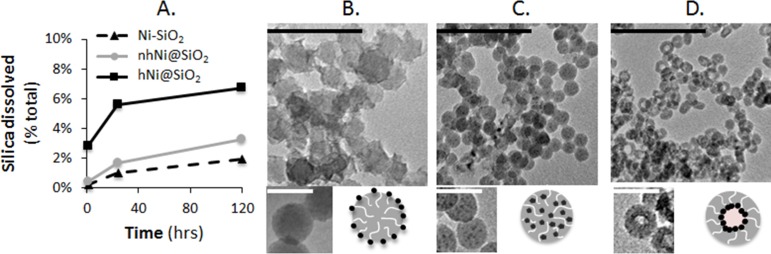
A. % total SiO2 dissolution from CENs dispersed in E3 medium for five days at room temperature with a starting concentration of 200 mg Ni/L. TEM images on day five of B. Ni-SiO2, C. nhNi@SiO2 and D. hNi@SiO2. Scale bars are 200 nm for larger images (black) and 50 nm for smaller pictures (white). All three CENs exhibited minimal silica dissolution.